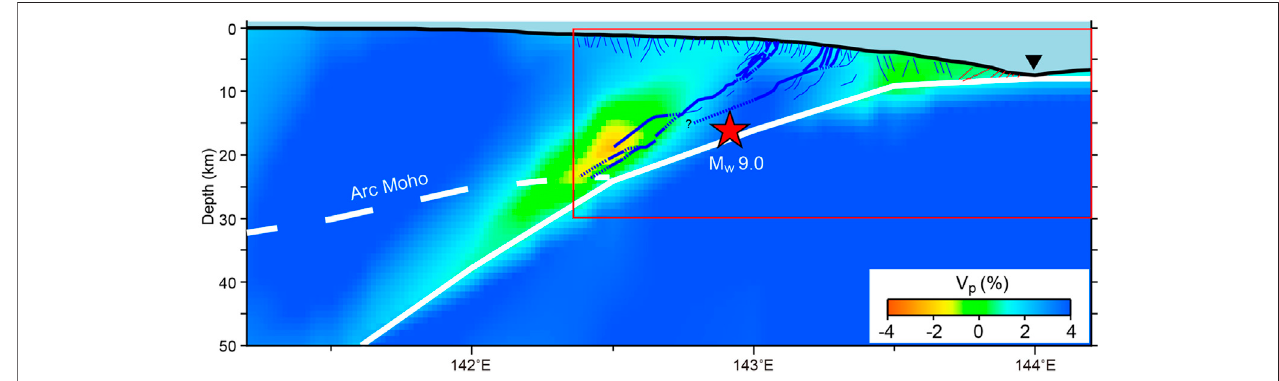
FIGURE 6 | P-wave tomographic image (Liu and Zhao, 2018) along the pro fi le B ( Figure 1 ). Fault interpretations ( Figure 2B ) on the PSDM pro fi le of line D6 are shown in red box. The red star marks the hypocenter of the 2011 Tohoku mainshock (M w 9.0).